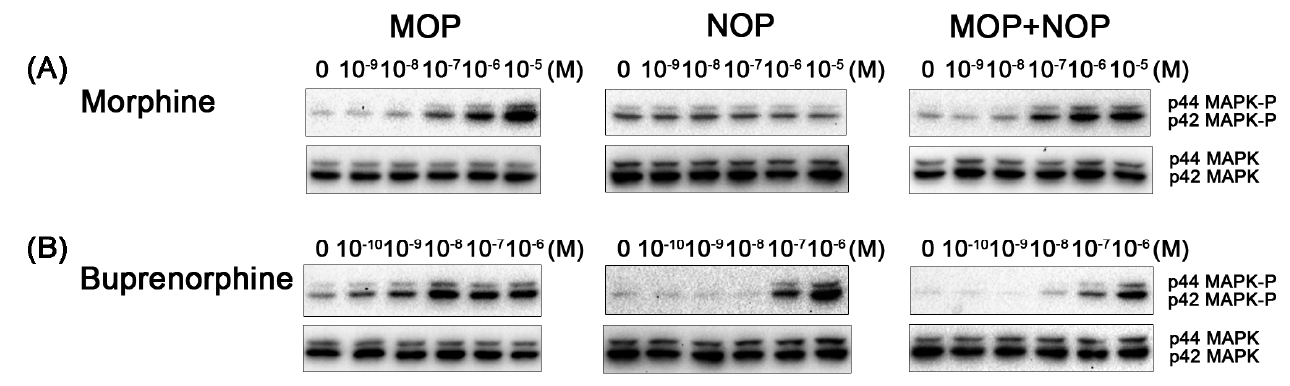
Figure 4. Representative immunoblots of Erk1/2 (p44/p42 MAPK) phosphorylation after stimulation with ( A ) morphine and ( B ) buprenorphine in cells stably expressing MOP, NOP, and MOP+NOP receptors. Immunoblotting using anti-phospho-p44/p42 MAPK (Erk1/2) rabbit polyclonal and anti- p44/42 MAPK (Erk1/2) rabbit monoclonal antibodies was performed to visualize opioid-induced phosphorylation of Erk1/2 (p44 MAPK-P and p42 MAPK-P) and total Erk1/2 (p44 MAPK and p42 MAPK), respectively. ( C ) Dose ‒ response curves of the immunoblots. The density of phospho- p44/p42 MAPK versus the density of p44/42 MAPK in control cells (with vehicle treatment) was considered to be 1. All the experiments were repeated no less than four times, and the values repre- sent the average ± SE. 3. Discussion Our study is the first to show how the localization of MOP and NOP receptors and the phosphorylation of Erk1/2 were modulated by opioids in HEK 293 cells coexpressing MOP and NOP receptors. The two-photon fluorescence of MOP-CPF and NOP-YFP (Figure 1) revealed the en- dogenous proximity of MOP and NOP (35% FRET ratio), and a subpopulation of the re- ceptors displayed a higher FRET ratio (61% FRET ratio in addition to 43% FRET) after morphine addition, indicating that some of the MOP and NOP became closer in the pres- ence of morphine. This phenomenon was not observed for buprenorphine (39% FRET). Since CFP and YFP were fused to the C-termini of MOP and NOP, respectively, in our